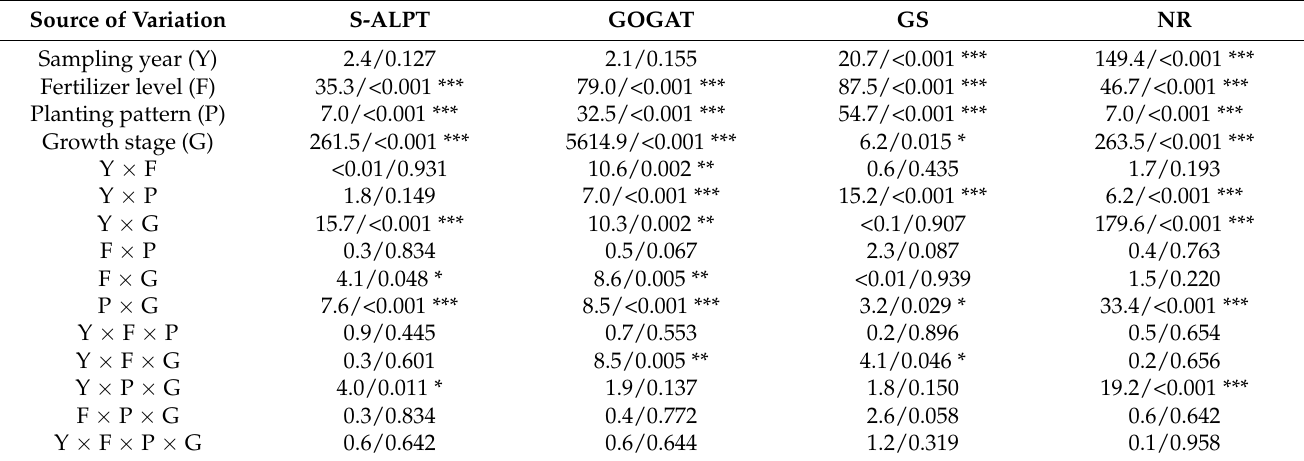
Table 3. Four-factor analysis of variance (ANOVA) of the effects of sampling years (Y; 2018 vs. 2019), fertilizer levels (F; normal vs. reduced), intercropping planting pattern (P; sole-crop soybean and three intercropping planting patterns of soybean with corn), growth stage (G; R2 vs. R5) and their bi-/tri-/quad-interactions on nitrogen-metabolization-related enzymes in soil (S-ALPT) and soybean leaves (GOGAT, GS and NR) ( F / p value).